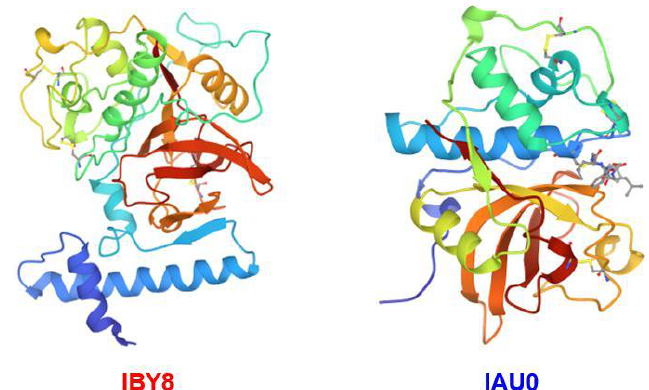
Figure 1. Three-dimensional structure of pro-cathepsin k and cathepsin k. Structures generated on the PDB.